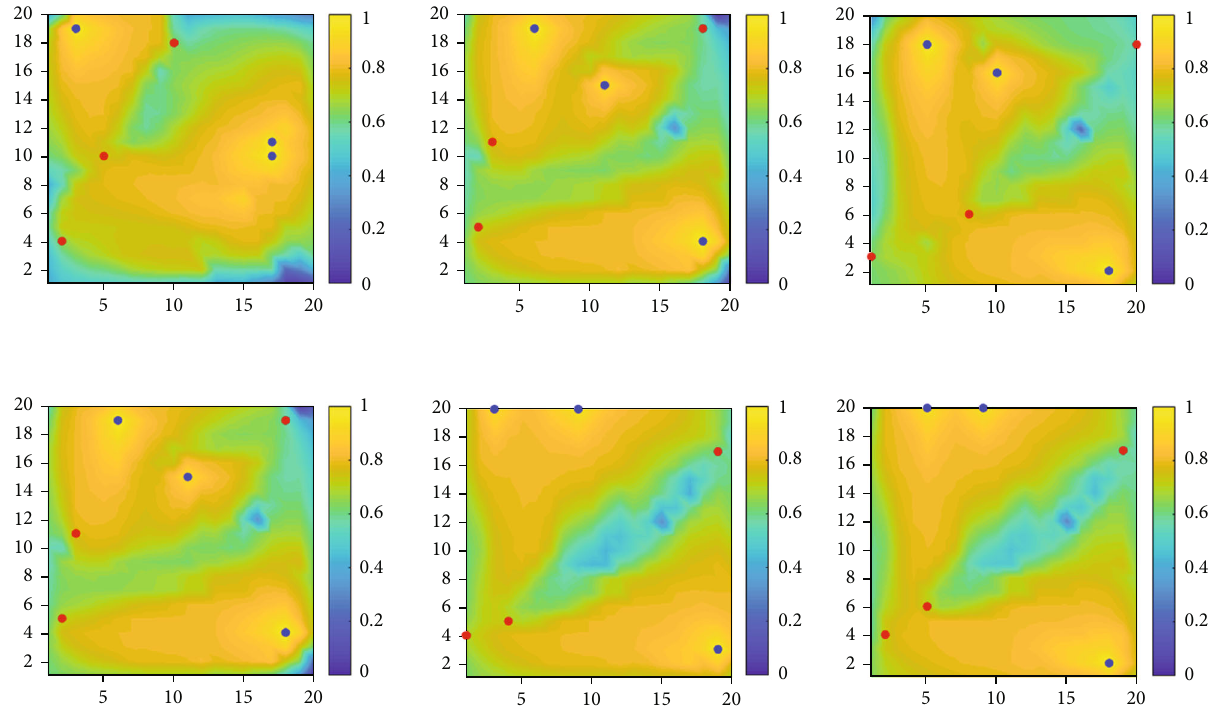
Figure 15: The optimal well locations plotted on the water saturation fi eld.